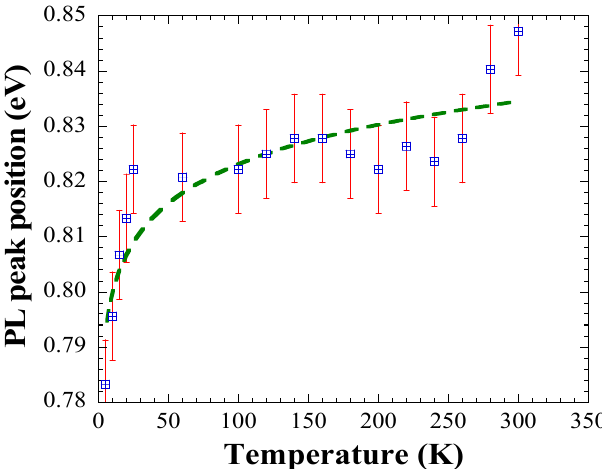
Figure 4. PL peak position versus temperature. The dashed line is a guide for the eyes.